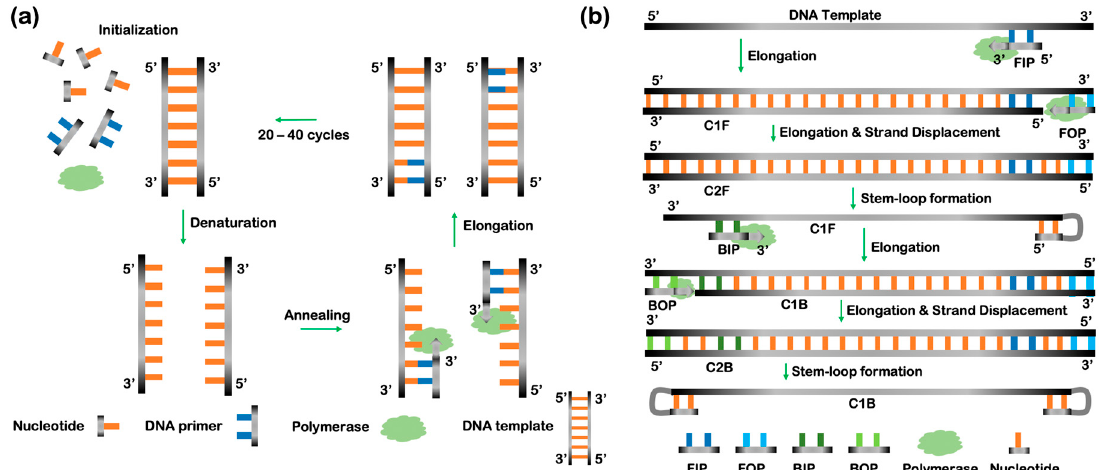
Figure 3. Enzyme-based techniques to detect disease biomarkers: ( a ) Polymerase chain reaction (PCR) uses polymerases, dNTPs, primers, and DNA template to synthesize exponential copies of the DNA template for signal detection and amplification via multiple thermal cycles; ( b ) Loop-mediated isothermal amplification (LAMP) extends the utility of PCR without requiring thermal cycling. Under isothermal conditions, four primers (FIP, FOP, BIP, BOP) sequentially hybridize to the DNA template while the polymerase simultaneously synthesizes C1F, C2F, C1B, and C2B copies of the template. The final stem-loop copy (C1B) is exponentially amplified for signal detection.